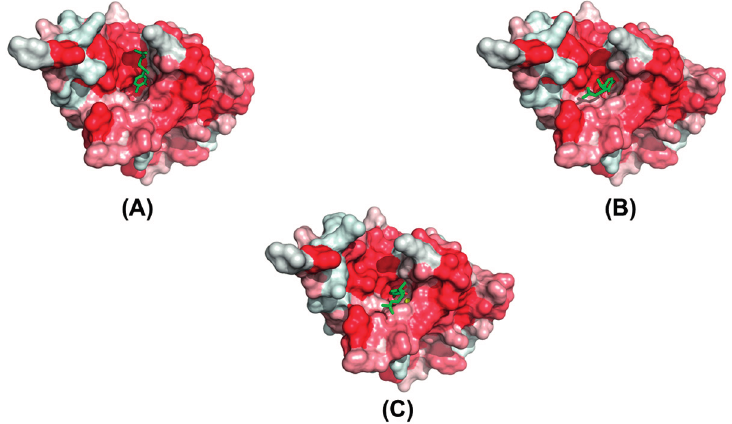
Figure 3. The hydrophobic surfaces of the wild-type and mutant Ec TadA complexes: ( A ) wild type; ( B ) A143V; and ( C ) F149G. Representative structures extracted from